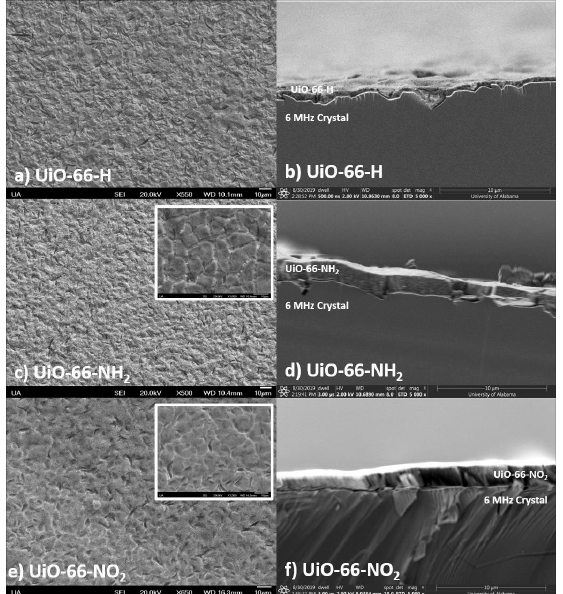
Figure 2. SEM images of UiO-66 films on QCM substrates. ( a ) Plane-view and ( b ) cross-sectional view of UiO-66-H. ( c ) Plane-view and ( d ) cross-sectional view of UiO-66-NH 2 . ( e ) Plane-view and ( f ) cross-sectional view of UiO-66-NO 2 .